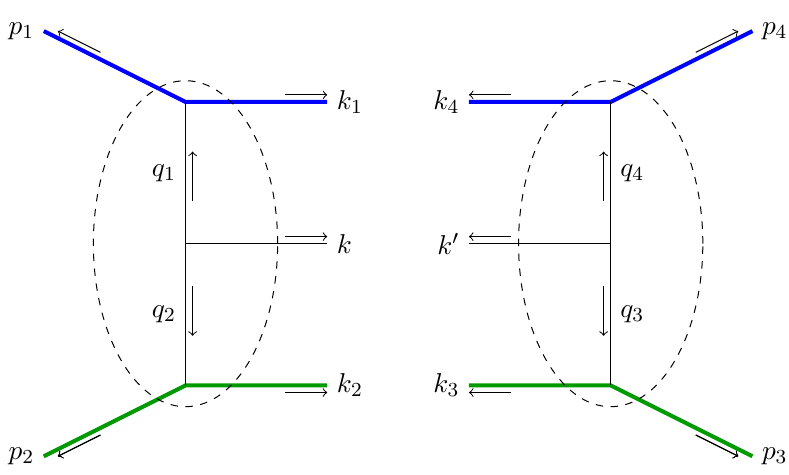
Figure 6. Kinematic conventions for the three-particle cut. The lines in bold represent classical states. The drawing inside the dashed bubbles does not represent a specific topology, but just provides a visual help to recall the definition of the q i